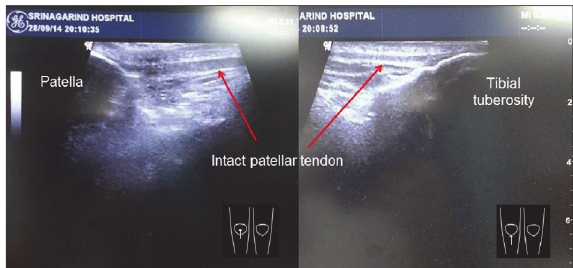
Figure 3: Under high frequency transducer (8MHz linear trans- ducer), the longitudinal scan showed multiple, parallel echogenic lines of the patellar tendon between the lower pole of the patella and the tibial tuberosity (arrowed). This ultrasound finding confirmed intact patellar